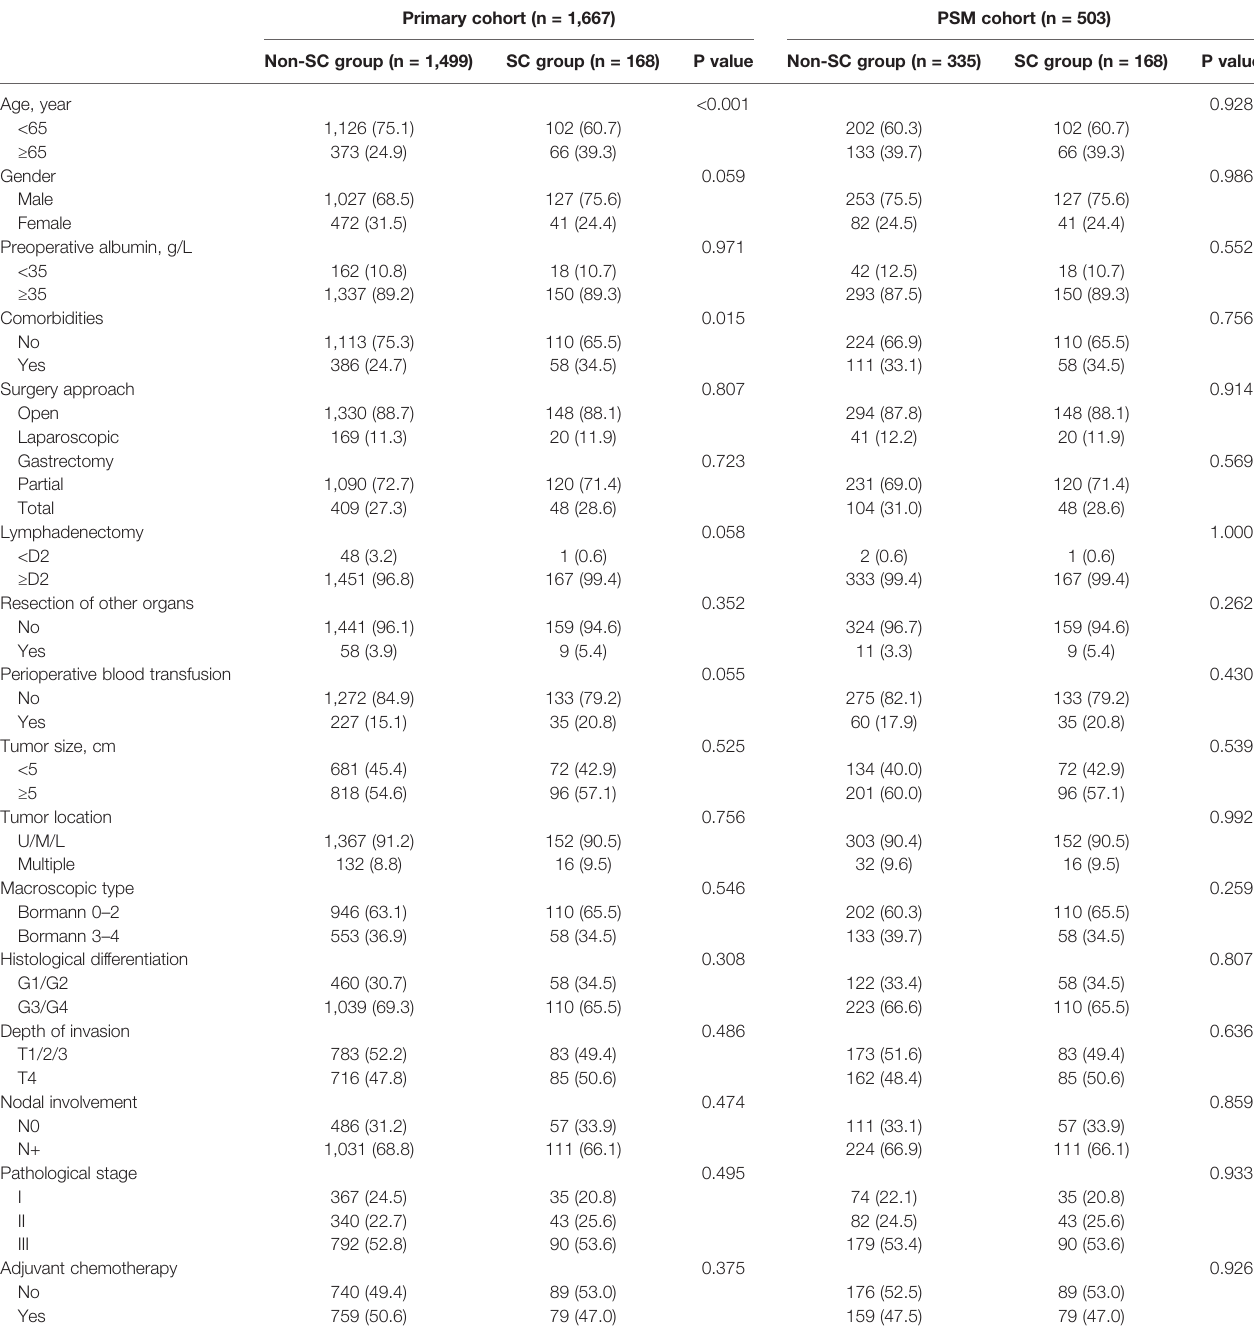
TABLE 1 | Baseline characteristics of gastric cancer patients before and after propensity score